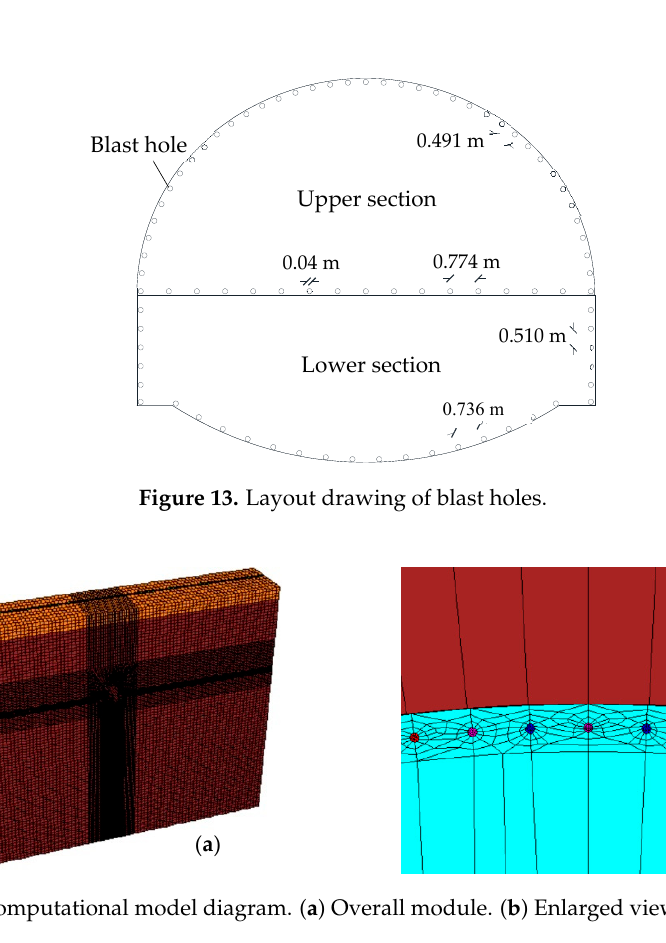
Figure 14. Computational model diagram. ( a ) Overall module. ( b ) Enlarged view of vault hole.